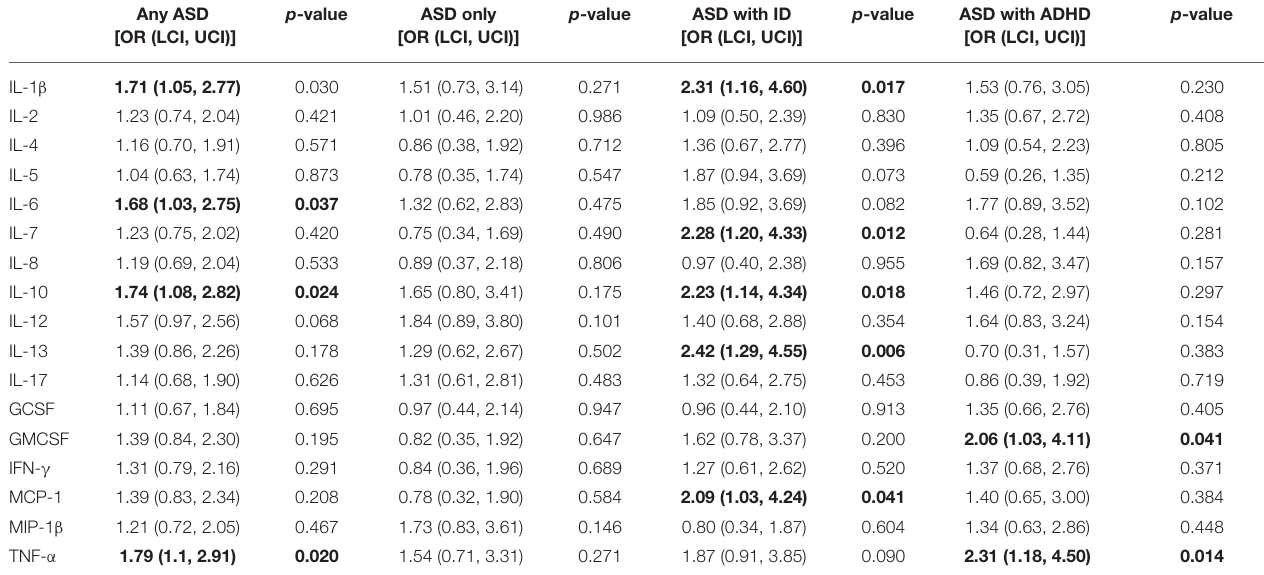
TABLE 3 | The adjusted relationship between cytokines and odds of ASD, stratified by co-occurrence of ID and ADHD, when comparing mothers of 318 ASD-cases to mothers of 429 unaffected individuals selected from the cohort. p -value ASD only p -value ASD with ID p -value ASD with ADHD p Any ASD [OR (LCI, UCI)] [OR (LCI, UCI)] [OR (LCI, UCI)] [OR (LCI, UCI)]